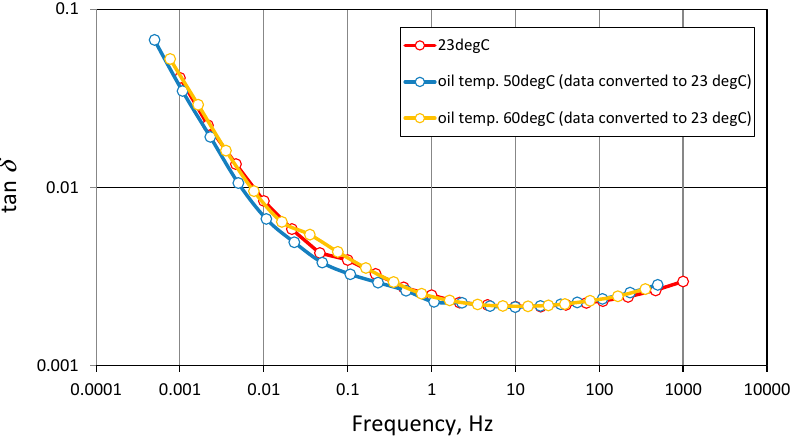
Figure 8. Dielectric response of the bushing insulation with non-uniform temperature distribution; measurements made at an ambient temperature of 23 °C; the temperature of the oil part was at 50 °C and 60 °C, subsequently converted to 23 °C, assuming an activation energy at the level of 0.9 eV.